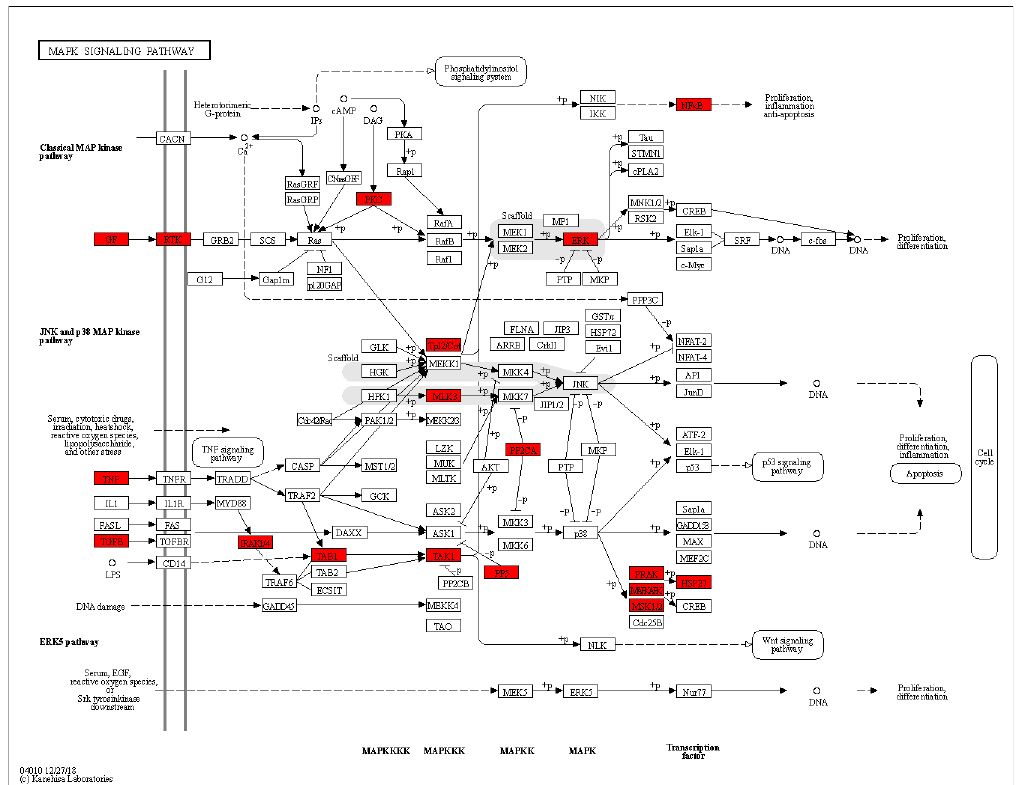
Figure 8. Mechanism of action of QHSSD in interfering with MAPK signaling pathway. Highlighted potential targets mediate MAPK signaling pathways to intervene in inflammation and angiogenesis.